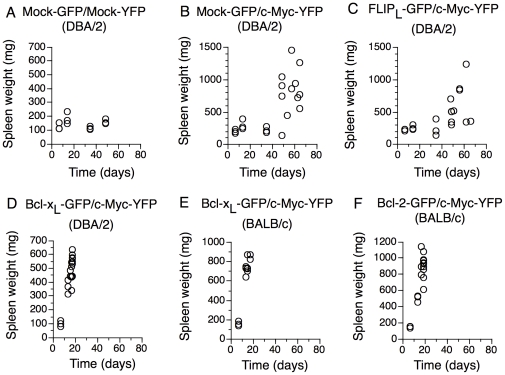
Over-expression of BCL-XL and BCL-2 accelerate Myc-induced splenomegaly whereas co-expression of FLIPL does not influence MYC-induced splenomegaly.Spleen weight of animals transplanted with HSC expressing (A) Mock-GFP/Mock-YFP into DBA/2 mice, (B) Mock-GFP/MYC-YFP into DBA/2 mice, (C) FLIPL-GFP/MYC-YFP into DBA/2 mice, (D) BCL-XL-GFP/MYC-YFP into DBA2 mice, (E) BCL-XL-GFP/MYC-YFP into BALB/c mice and (F) BCL-2-GFP/MYC-YFP into BALB/c. Spleens of mice at control time points (7 days, 14 days, 35 days and 49 days after transplantation) and spleens of all moribund mice were weighed. Each dot represents one mouse.